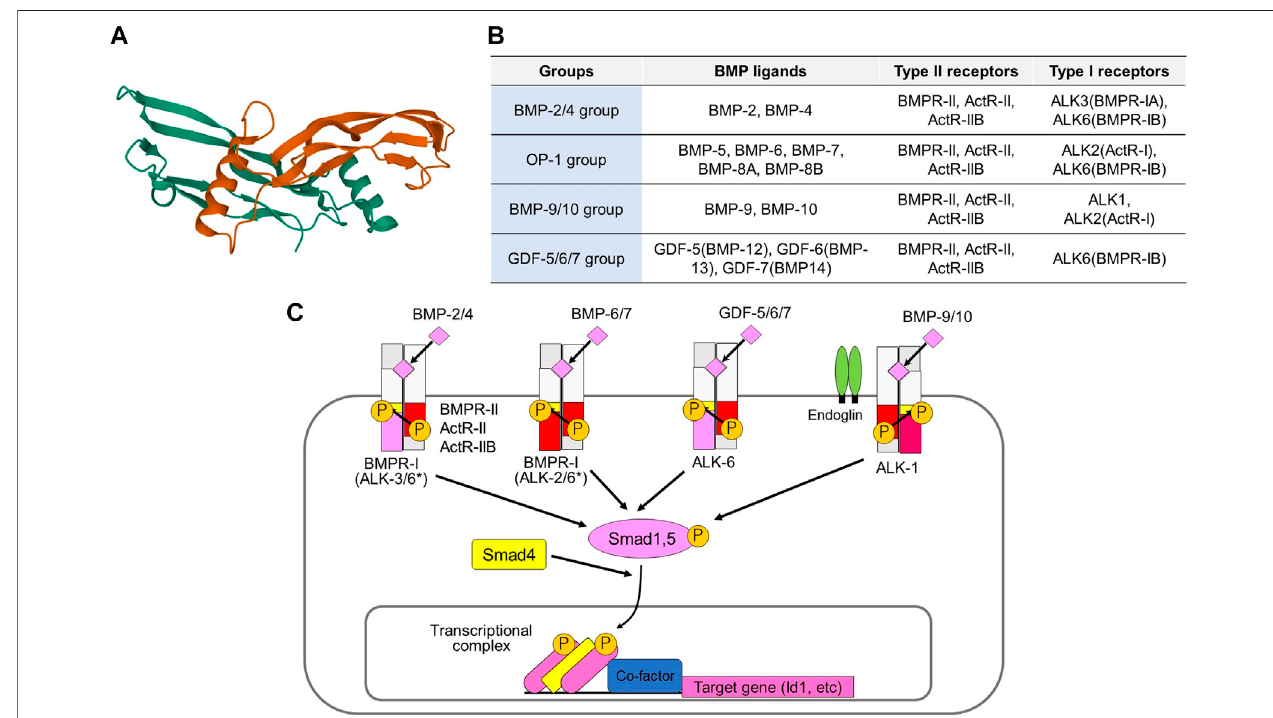
FIGURE 1 | Activation of BMP signaling pathways by various BMP ligands and type II and type I receptors. (A) Three-dimensional structure of human BMP-6 homodimer. This fi gure iscreated based on the PDB information deposited by Juo and Seeherman (https://www.rcsb.org/structure/6OMO). (B) Classi fi cation of BMPs basedontheir bindingaf fi nitiestoreceptors. (C) BMPR-II, ActR-II, and ActR-IIBaretype IIreceptors,while ALK1,ALK2,ALK3,andALK6 aretype IreceptorsforBMPs. Thebindingpro fi lesofBMP-2/4group,theBMP-5/6/7/8group,theGDF-5/6/7group,andtheBMP-9/10grouptotypeIreceptorsareshown.*BMPsofBMP-2/4 group preferentially bind to ALK3 and ALK6, while those of OP-1 group mainly bind to ALK2 and ALK6. However, BMP-2/4 may transduce signals through ALK2, while OP-1 group ligands may transduce signals through ALK3 under certain conditions. Type II and type I receptors form a heteromeric complex and transduce intracellular signals by phosphorylating Smad1/5, as well as through non-Smad signaling pathways. The phosphorylated Smads form complexes with Smad4 and associate with various transcription factors and transcriptional coregulators in the nucleus, thereby regulating transcription of the target genes, including ID1.